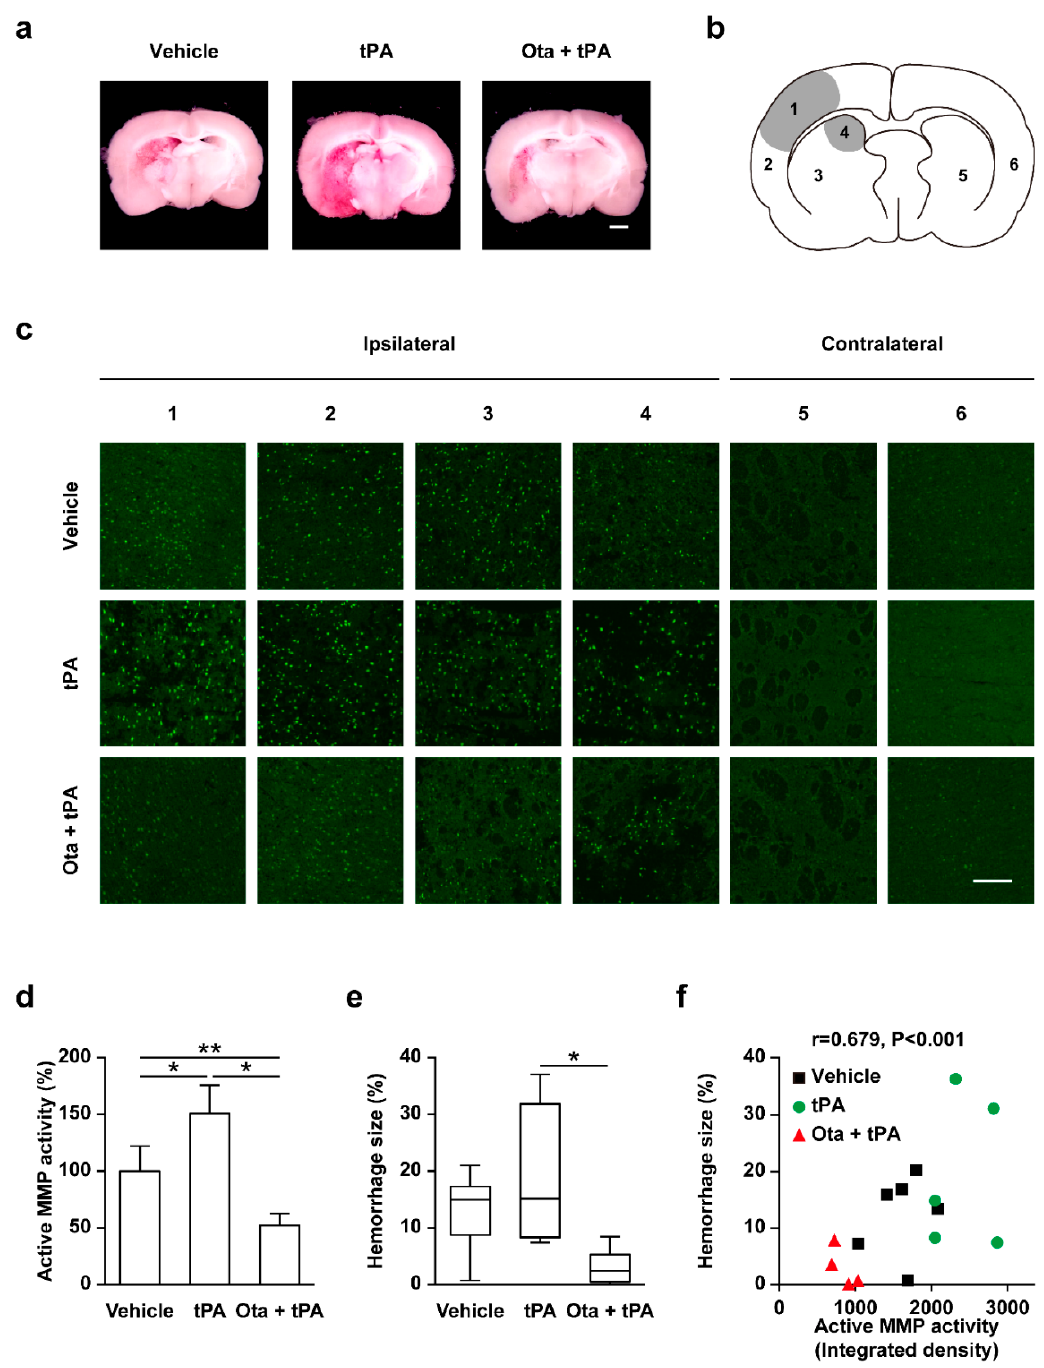
Figure 2. Reduction of MMP activity and hemorrhage size by otaplimastat (Ota). ( a ) Representative brain slices (scale bar = 100 μ m). ( b ) Schematic representation of whole brain. ( c ) Representative in situ gelatin zymography of the area shown in ( b ). Quantification of MMP activity ( d ) and microscopic hemorrhage ( e ) measured 7 h after embolism in the vehicle, rtPA and otaplimastat/rtPA groups, and correlation between MMP activity and hemorrhage volume ( f ). Quantified data are expressed as means ± S.D. Microscopic hemorrhage volumes are expressed as median ± interquartile rages (Q1 to Q3). Statistical differences were analyzed with Kruskal–Wallis followed by Mann–Whitney test, * p < 0.05 and ** p < 0.01. Correlation between MMP activity and hemorrhage volume determined using the Spearman’s test (R = 0.679, p < 0.001; n = 4–6 per group).